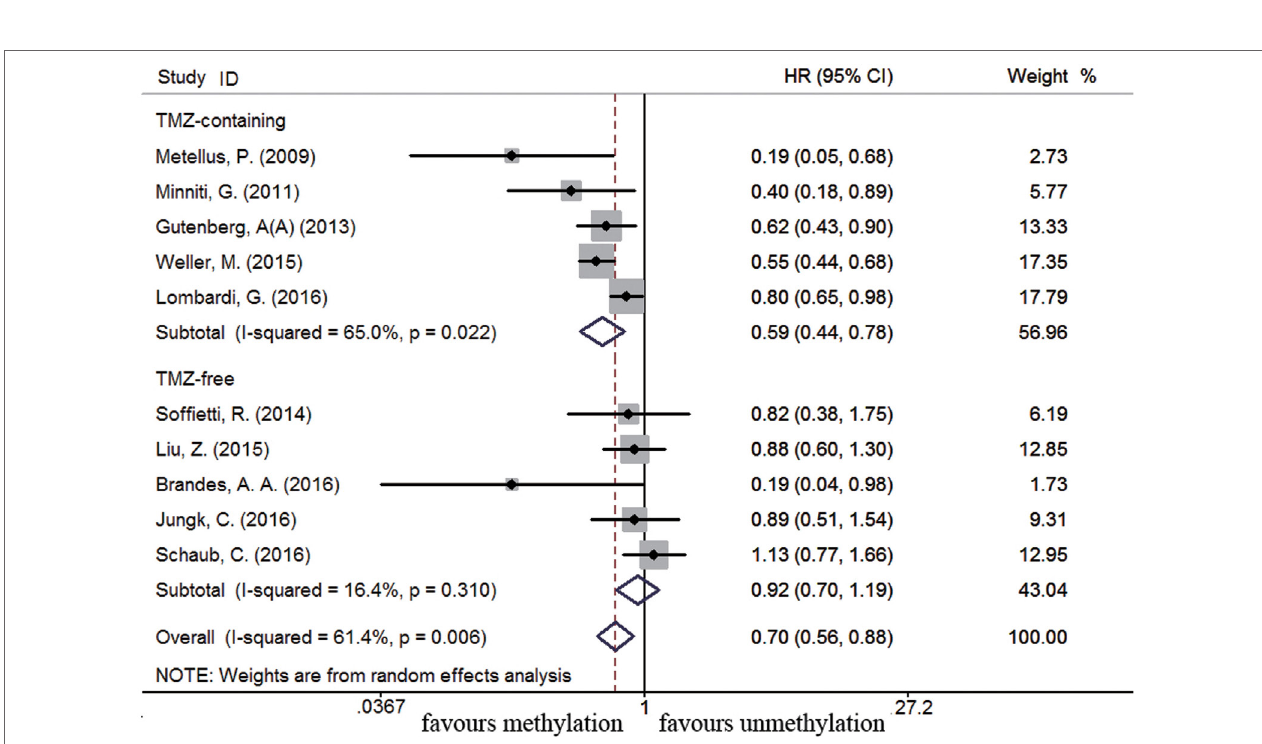
FiGURe 8 | Calculated HRs and 95% CIs for the relationship between methylation and OS benefit in elderly GBM patients exposed to TMZ alone or radiotherapy (RT) alone (methylated vs. unmethylated